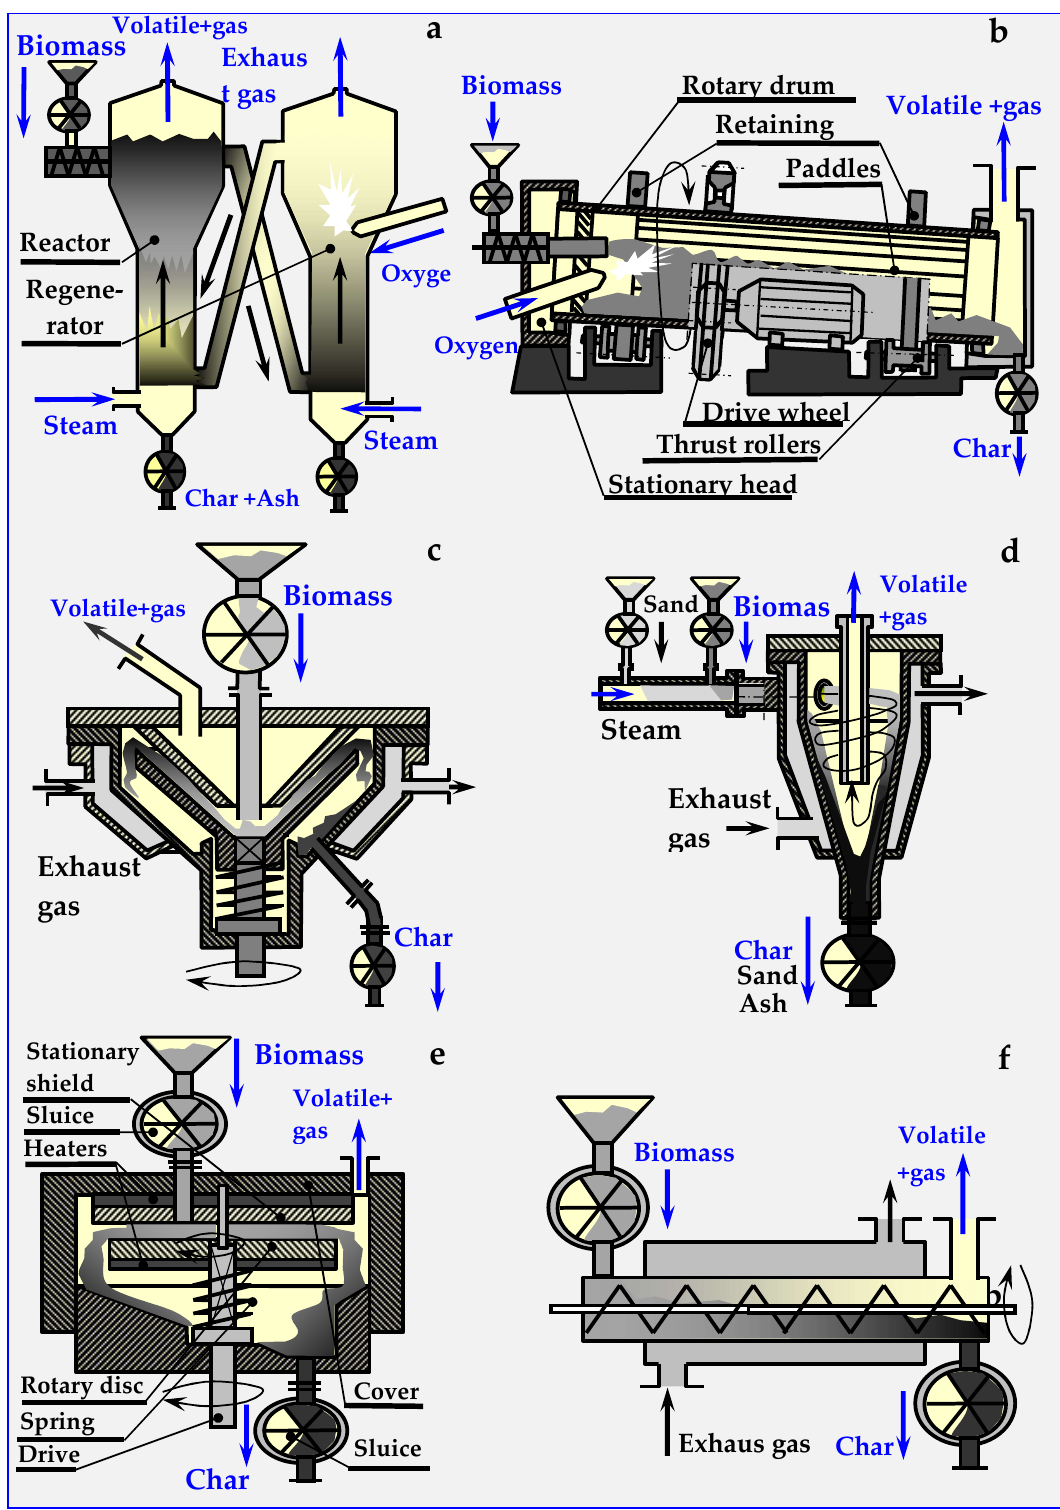
Figure 16. Schemes of the most popular reactors and devices for biomass pyrolysis: ( a ) Circulating fluidized bed, ( b ) Rotary kiln, ( c ) Conical, ( d ) Cyclone with an inert medium ( e ) Ablative and ( f ) Auger.